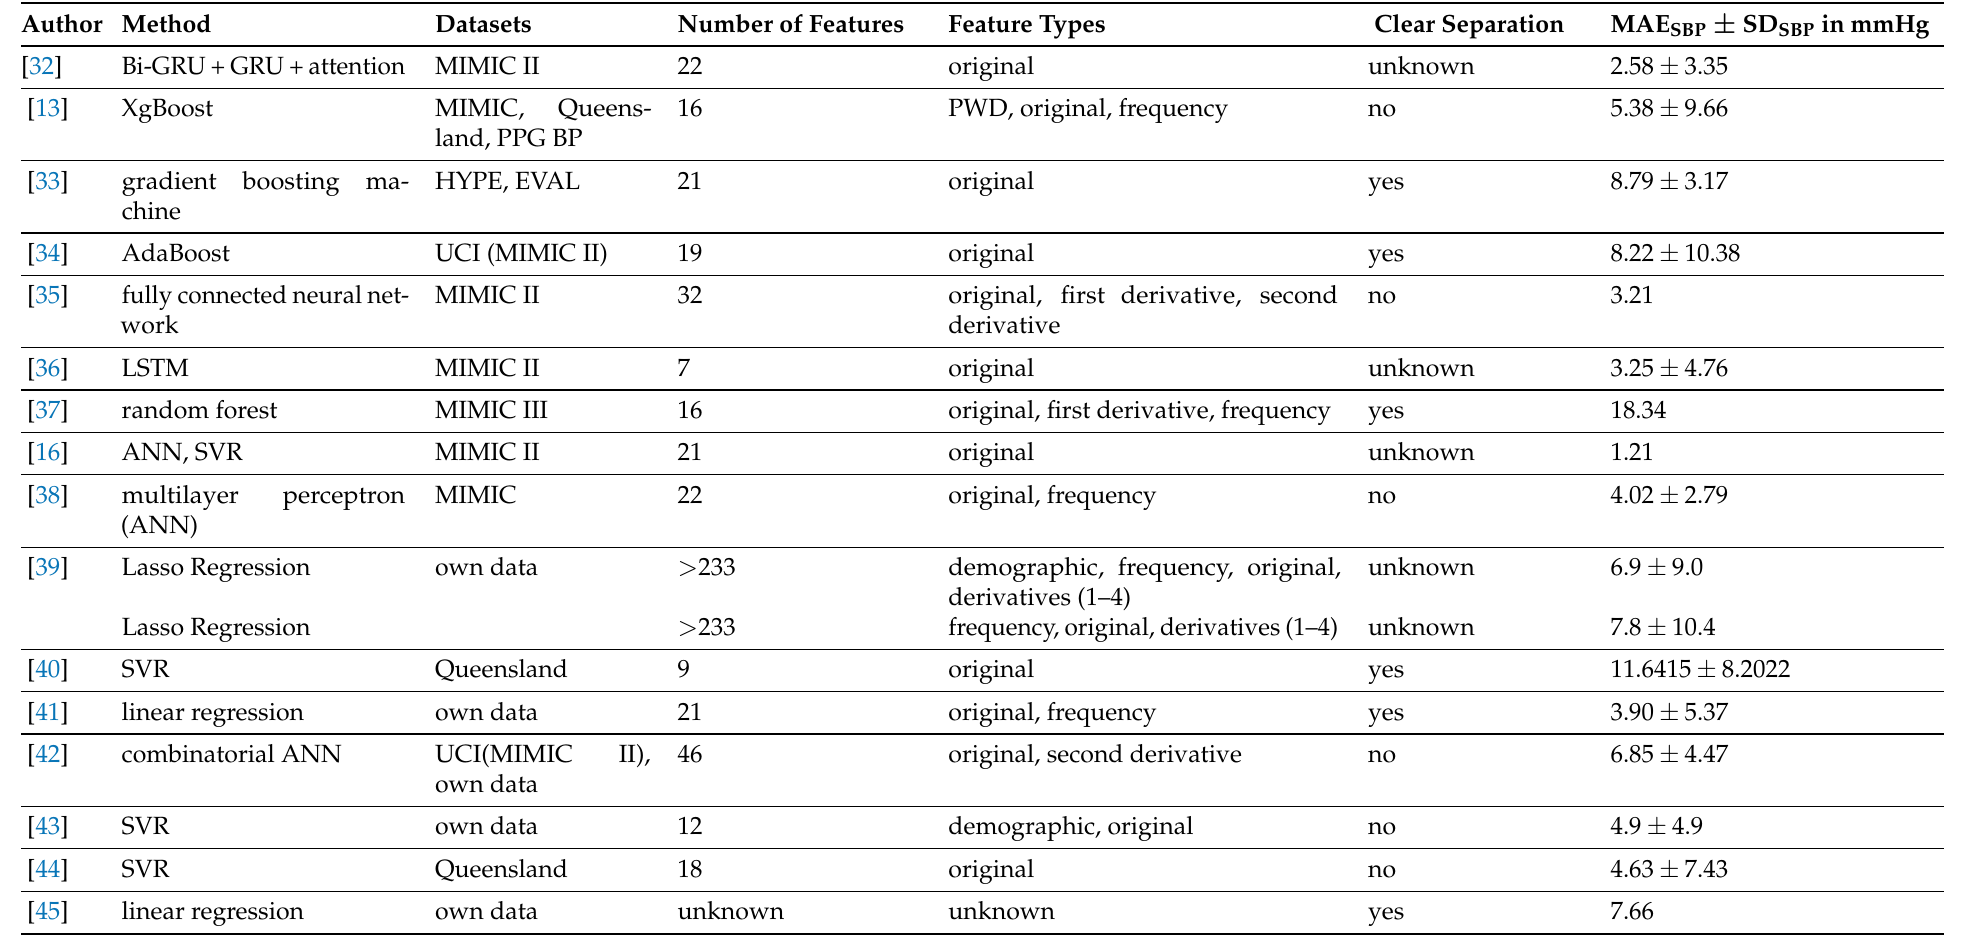
Table 1. Works regarding feature-based absolute BP estimation from PPG. Each entry reports the machine learning model, datasets, number of features and feature types used. The ‘Clear Separation’ column indicates whether the subjects are clearly separated into test and training data (‘yes’) or not (‘no’). Publications that do not declare their method of separation are labelled ‘unknown’. We show the best results achieved for each